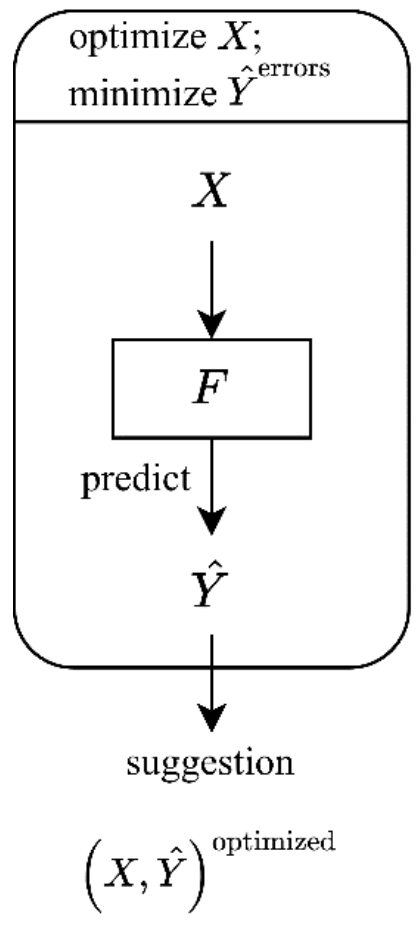
Figure 4. Suggestions are generated using an optimization algorithm with a neural network predict- ing model output ˆ Y .